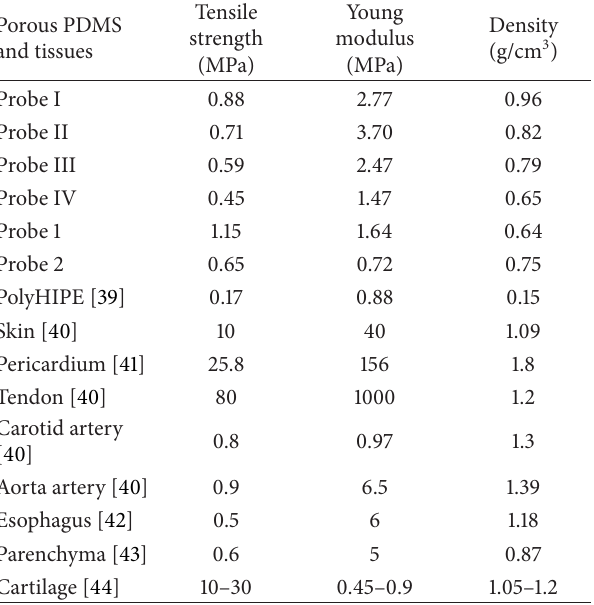
Table 1: Results’ summary from the mechanical characterization tests of the PDMS sponges obtained and comparative data from other porous polymers and natural soft